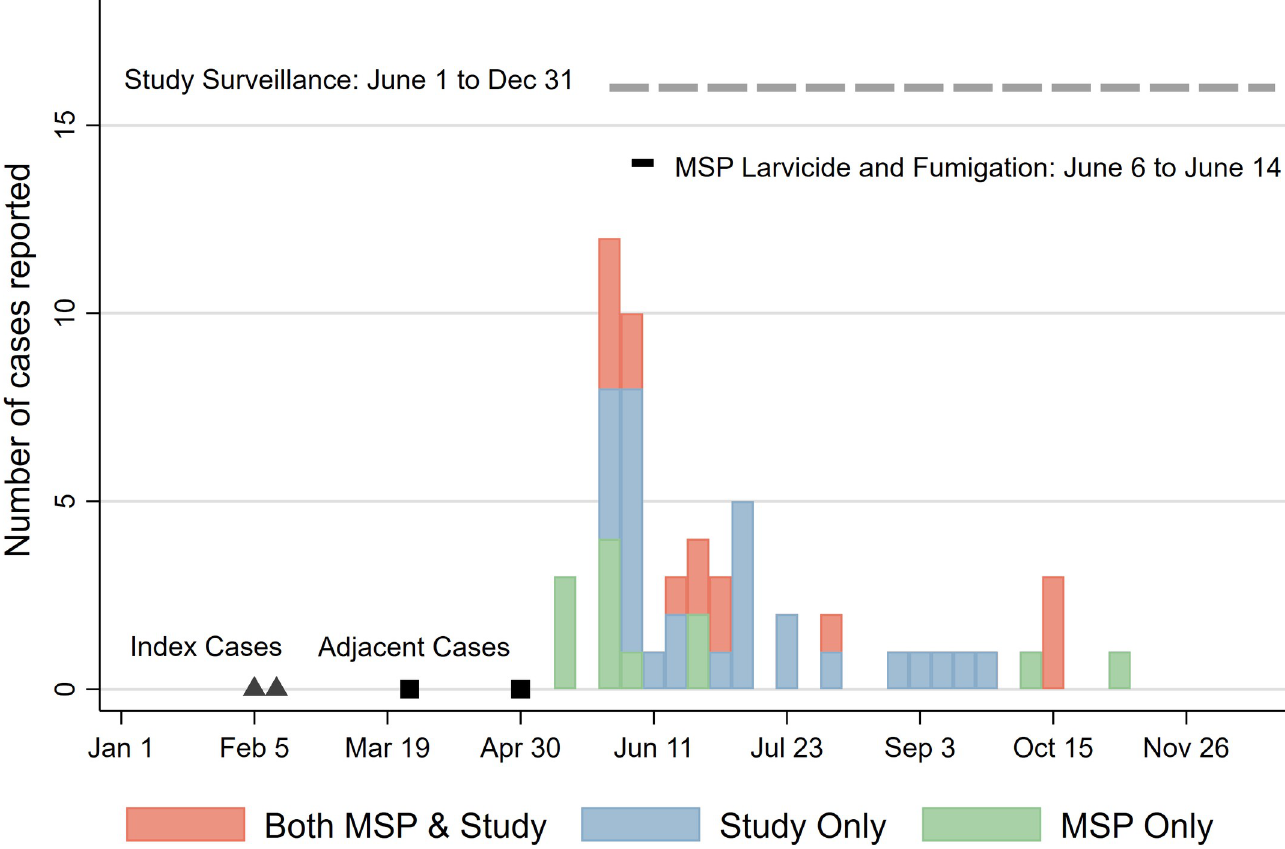
Fig 3. Cases identified by reported date of fever onset: Cases identified during the 2019 calendar year. Suspected index cases are represented by triangles, while adjacent cases (one from a person living in a nearby community, and one from a person diagnosed after returning from a trip to the village) are represented by square. From Jan 1 st to May 31 st , case detection was based on Ministry of Health (MOH) clinical records, from Jun 1 st to December 1 st , case detection was based of combined MOH and community-based active surveillance.